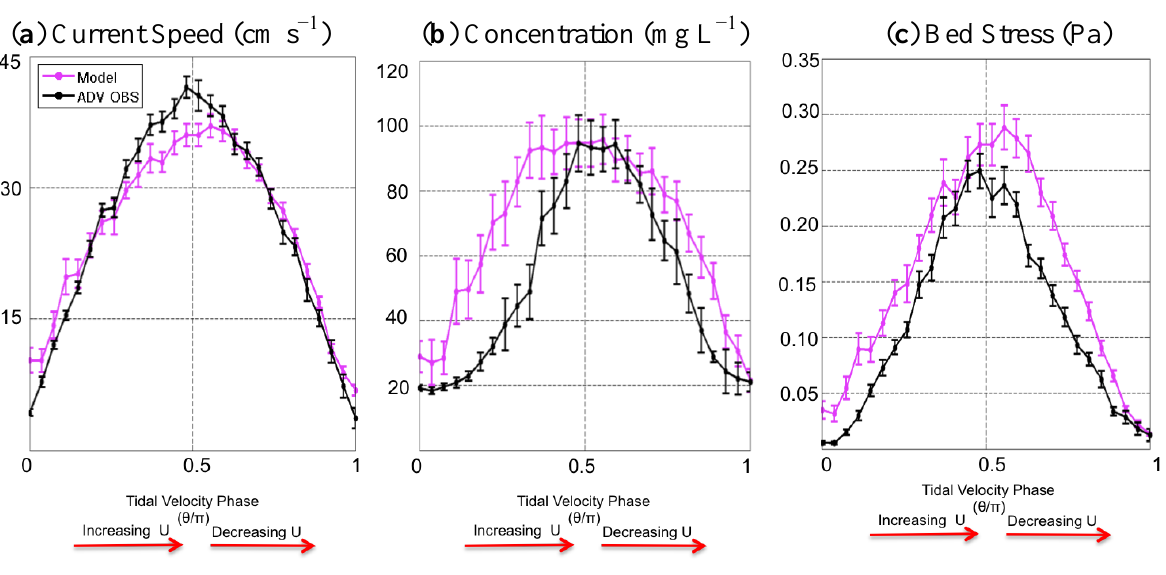
Figure 6. ADV and model estimated (see legend) ( a ) current speed, ( b ) concentrations, and ( c ) bed stresses for the top 20% of tidal cycles with strongest bed stresses. Error bars denote ±1 standard error.